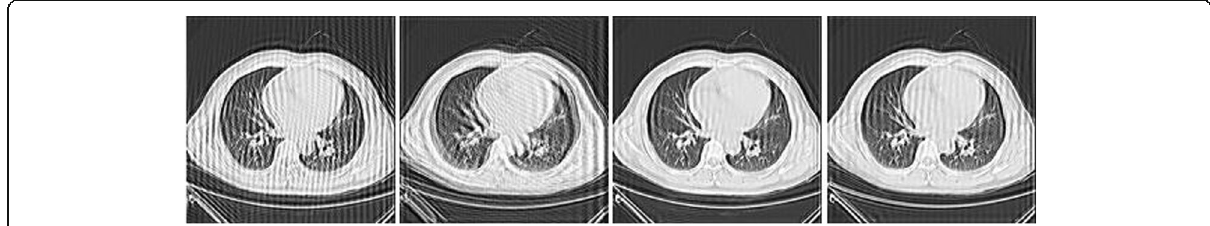
Fig. 3 Comparison of reconstructed images with different reconstruction methods (SNR = 20 dB)